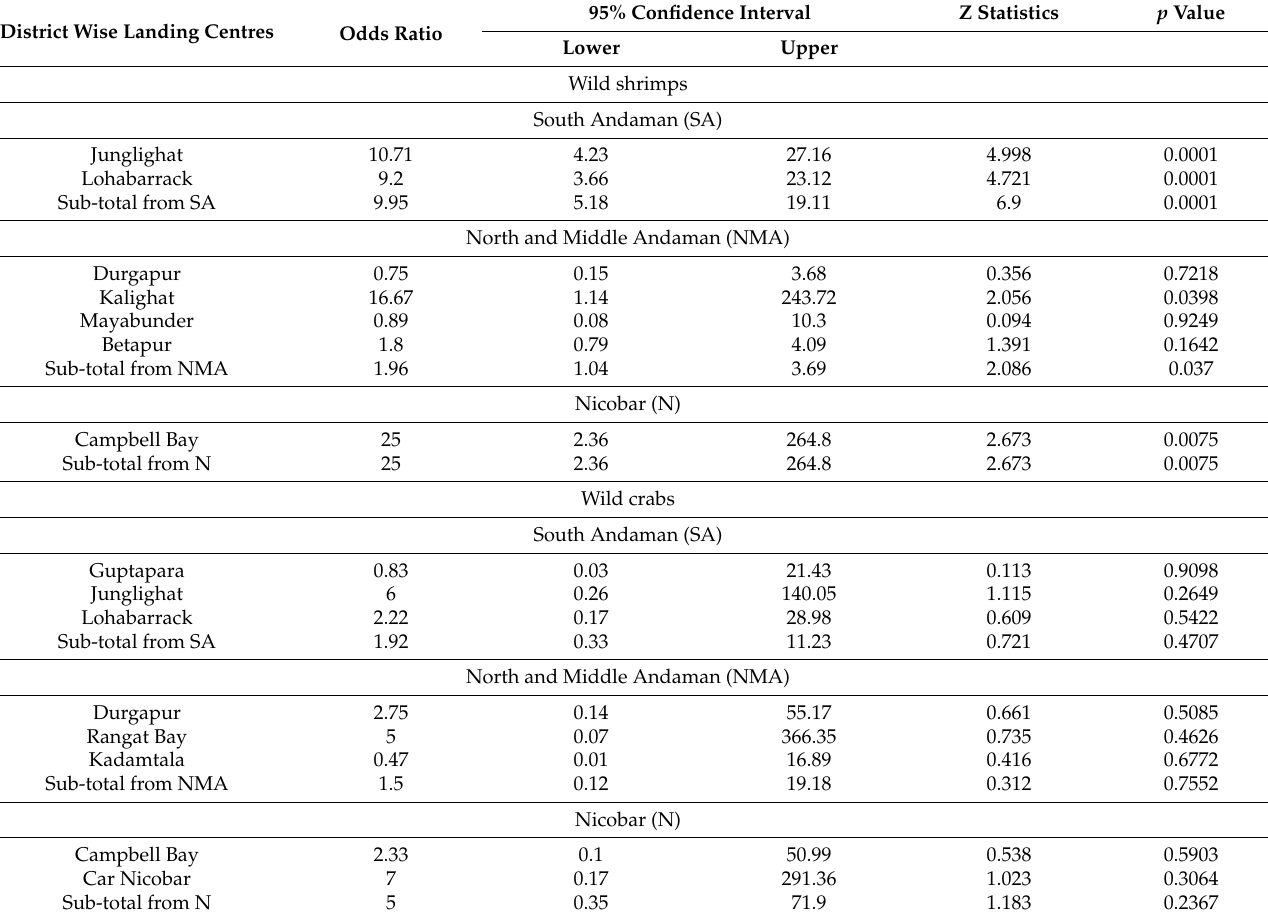
Table 4. Odds ratio values for co-infection of IHHNV and WSSV in wild shrimp and crab samples collected from various landing centres. The confidence interval was calculated by using MedCalc statistical software. If the 95% confidence interval excludes 1.0, the association is statistically significant at p < 0.05. If the 95% confidence interval includes 1.0, the association is not statistically significant at p <